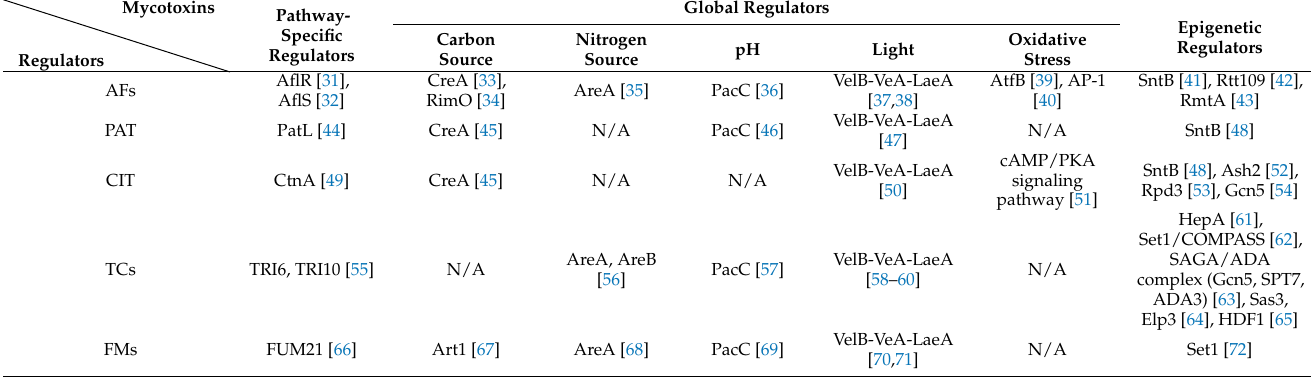
Table 2. Summary of current known regulators involved in the regulation of mycotoxin